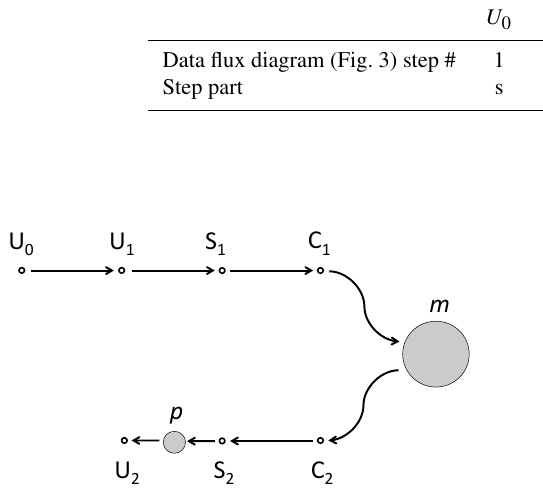
Figure 4. Graph structure of the TESSA system for running DSSs like VISIR. The nodes refer to points of time measurements: the user interface ( U ), the SSA platform ( S ), and the CDAM ( C ). The m (MATLAB job run) and the p (polling) nodes are displayed as larger filled circles for highlighting the fact that they contain the internal waiting times τ(m) and τ(p)